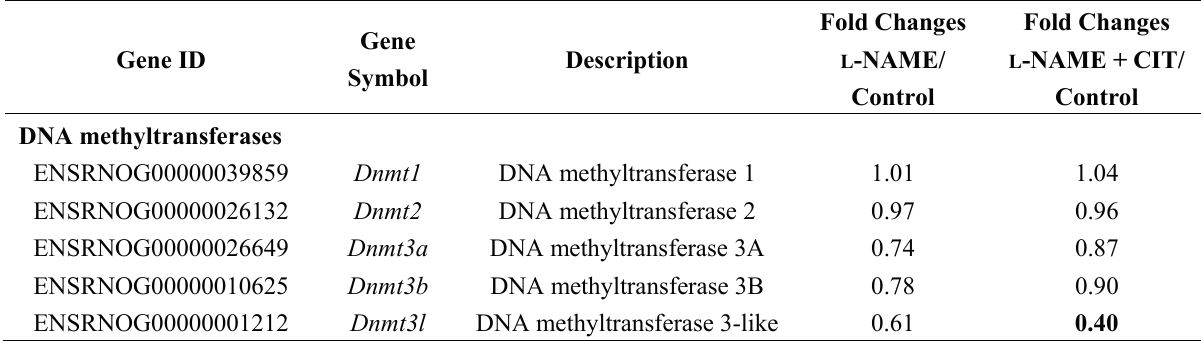
Table 4. Changes in genes involved in epigenetic regulation in the kidney of offspring at three months of age to maternal L -NAME and/or CIT vs.